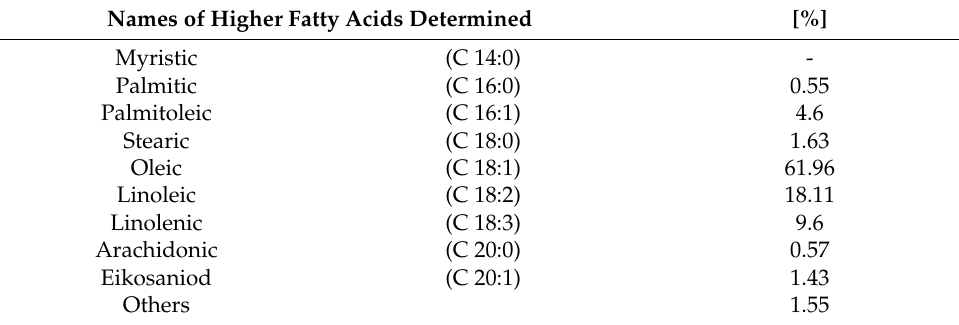
Table 3. Fatty acid profile of rapeseed oil methyl